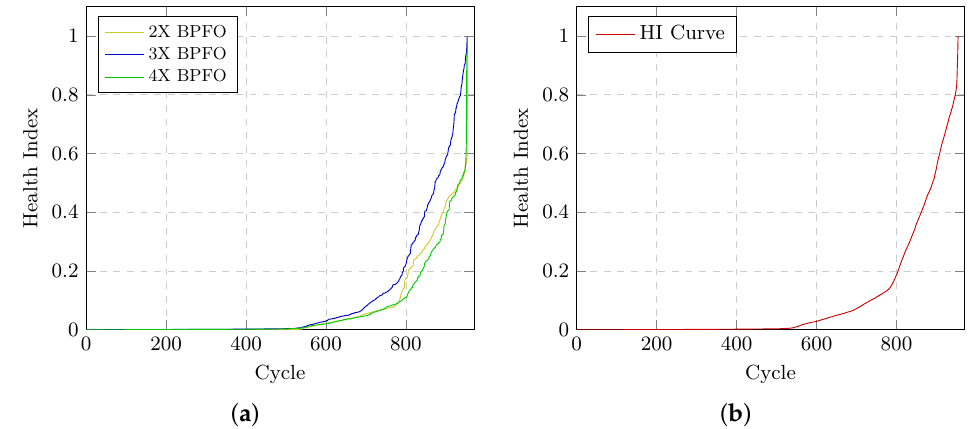
Figure 5. Normalized features and HI curve. ( a ) Normalized features. ( b ) HI